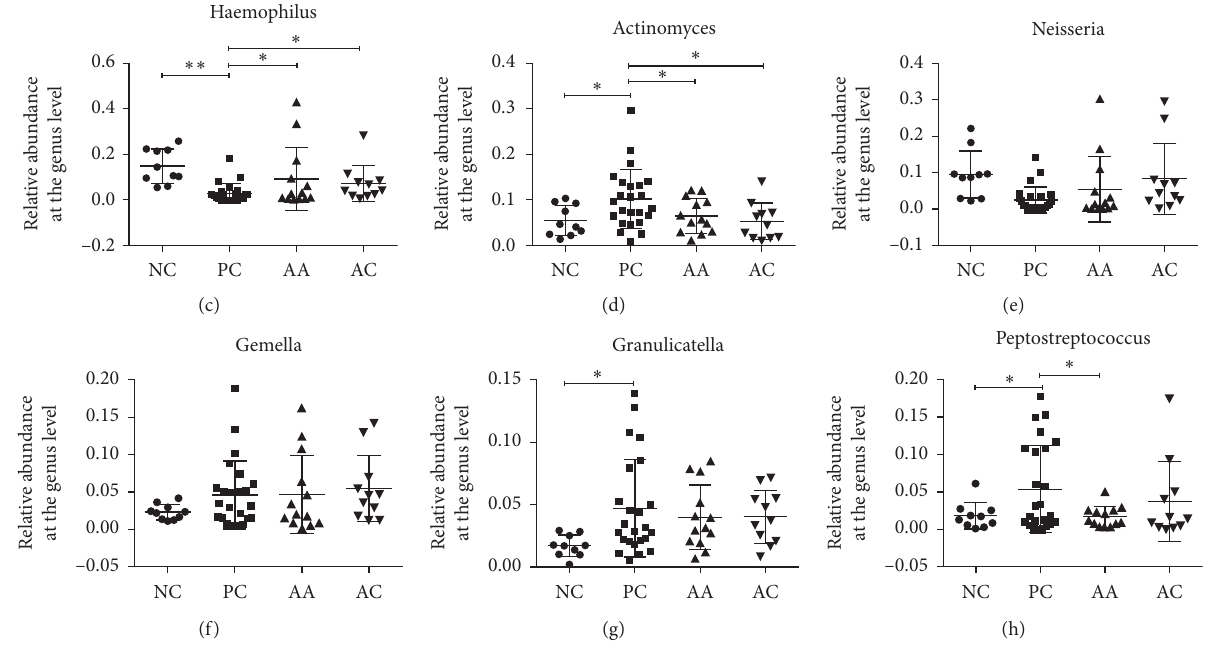
Figure 4: Evaluation of the aloe vera fermentation gel on the bacterial compositions at the genus level. (a) Taxonomic profiles at the phyla level in 58 saliva samples of the top 10 genera at the genus level. The relative abundances of (b) Streptococcus , (c) Haemophilus , (d) Actimomyces , (e) Neisseria , (f) Gemella , (g) Granulicatella , and (h) Peptostreptococcus . All data are shown as mean ± SD. Significant differences are denoted by ∗ p < 0 . 05 and ∗∗ p < 0 .